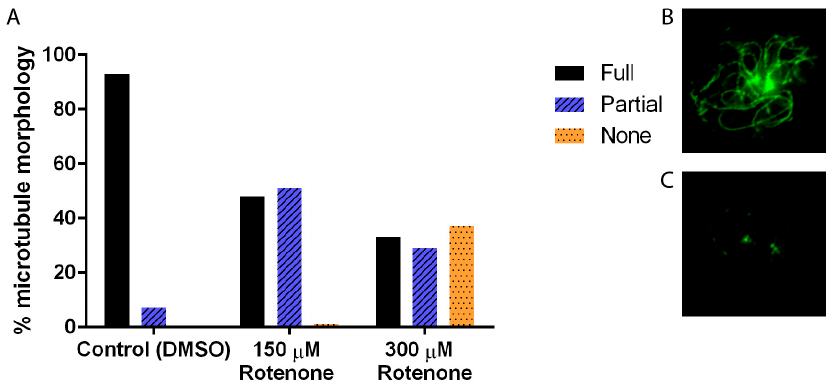
Figure 1. Microtubule morphology of cells treated with DMSO, 150 µ M, or 300 µ M of rotenone. ( A )